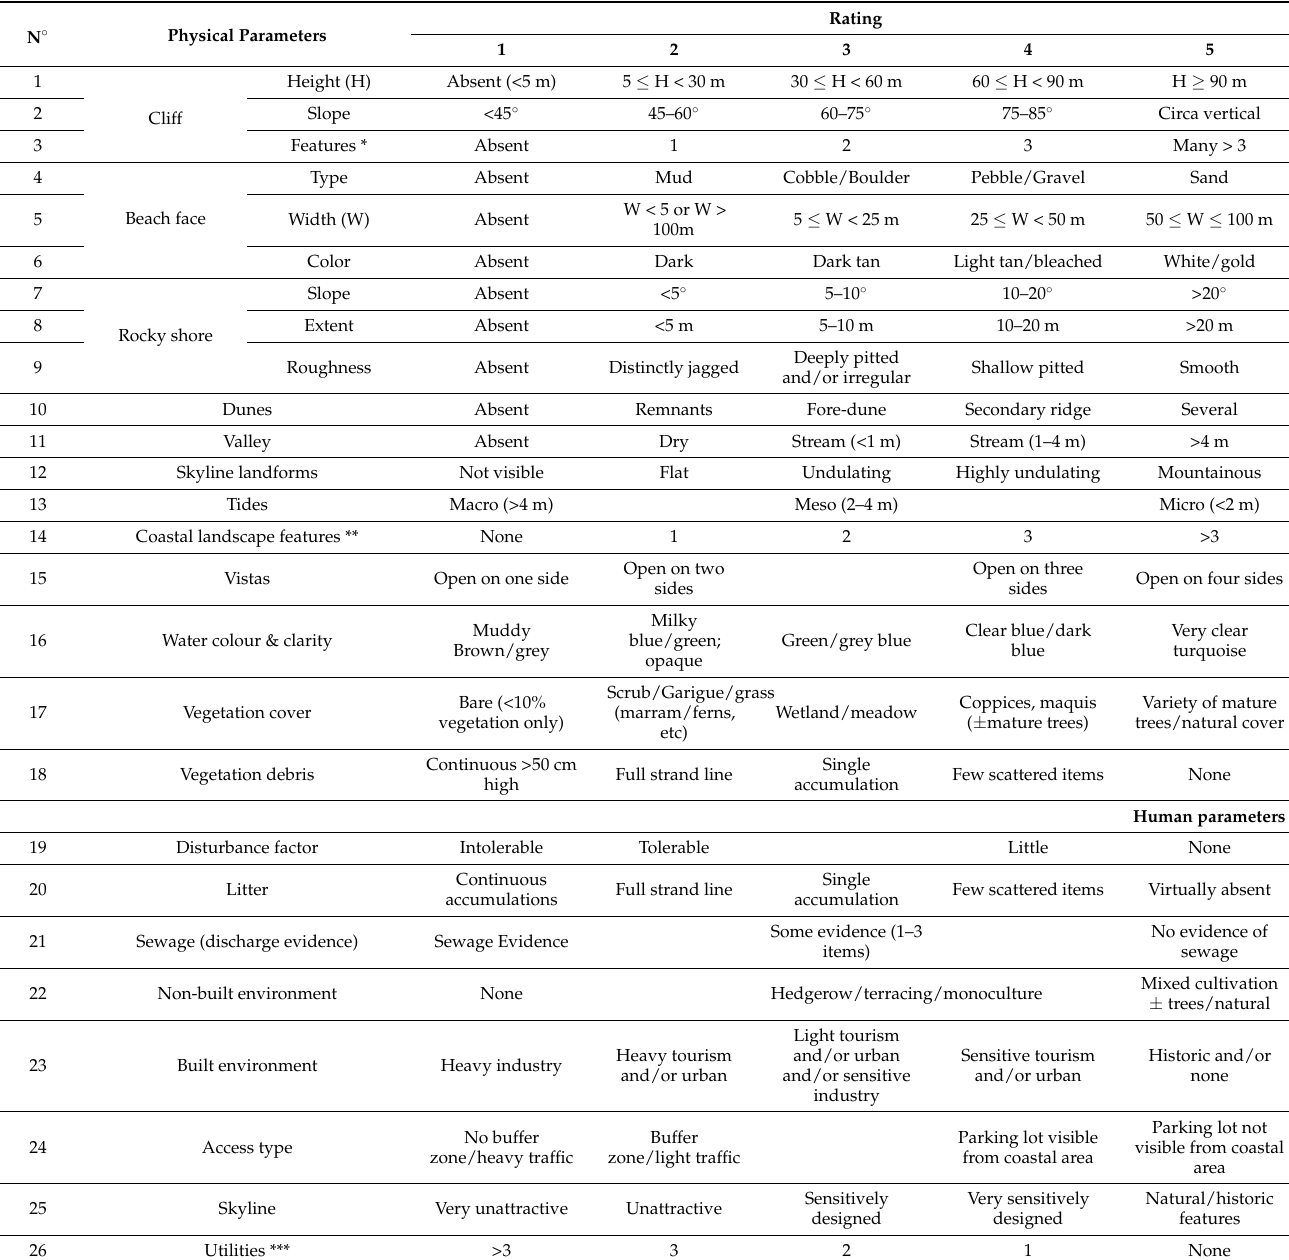
Table 1. Checklist parameters according to the CSES methodology